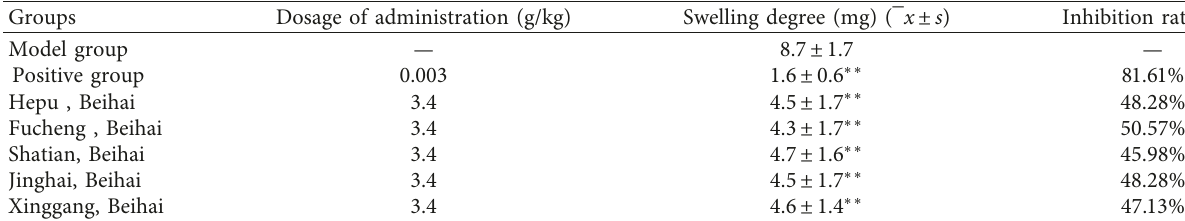
Table 3: Experimental results of ear swelling induced by dimethylbenzene in mice ( n � 8). Groups